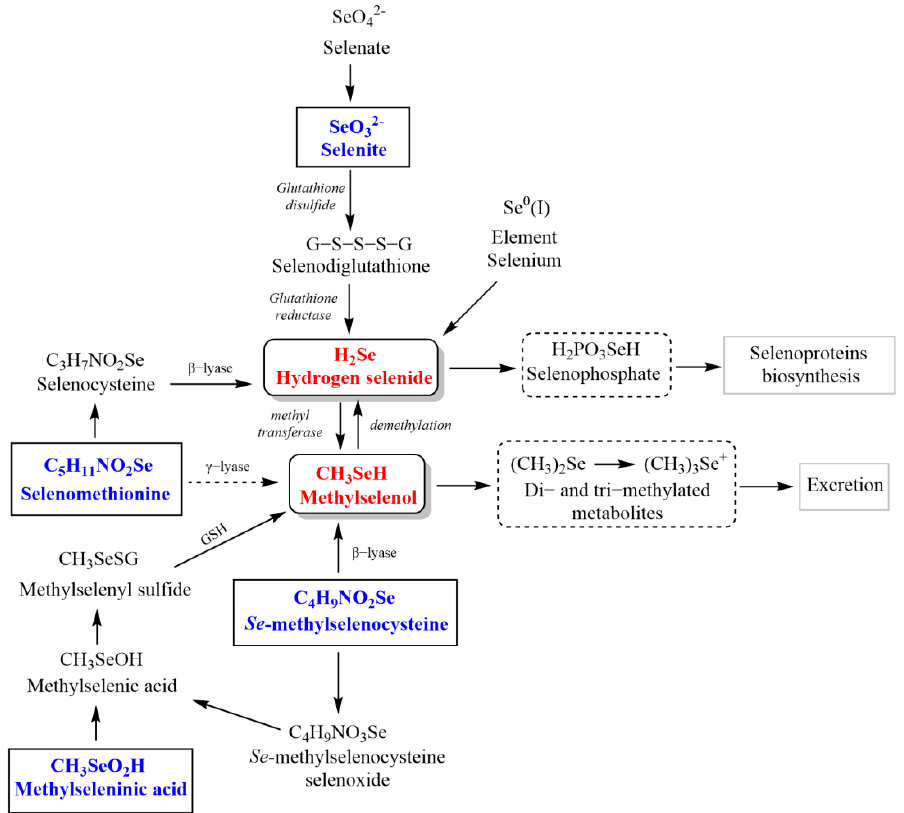
Figure 2. Metabolic pathways of some Se-containing compounds that are the precursors of H 2 Se and CH 3 SeH.